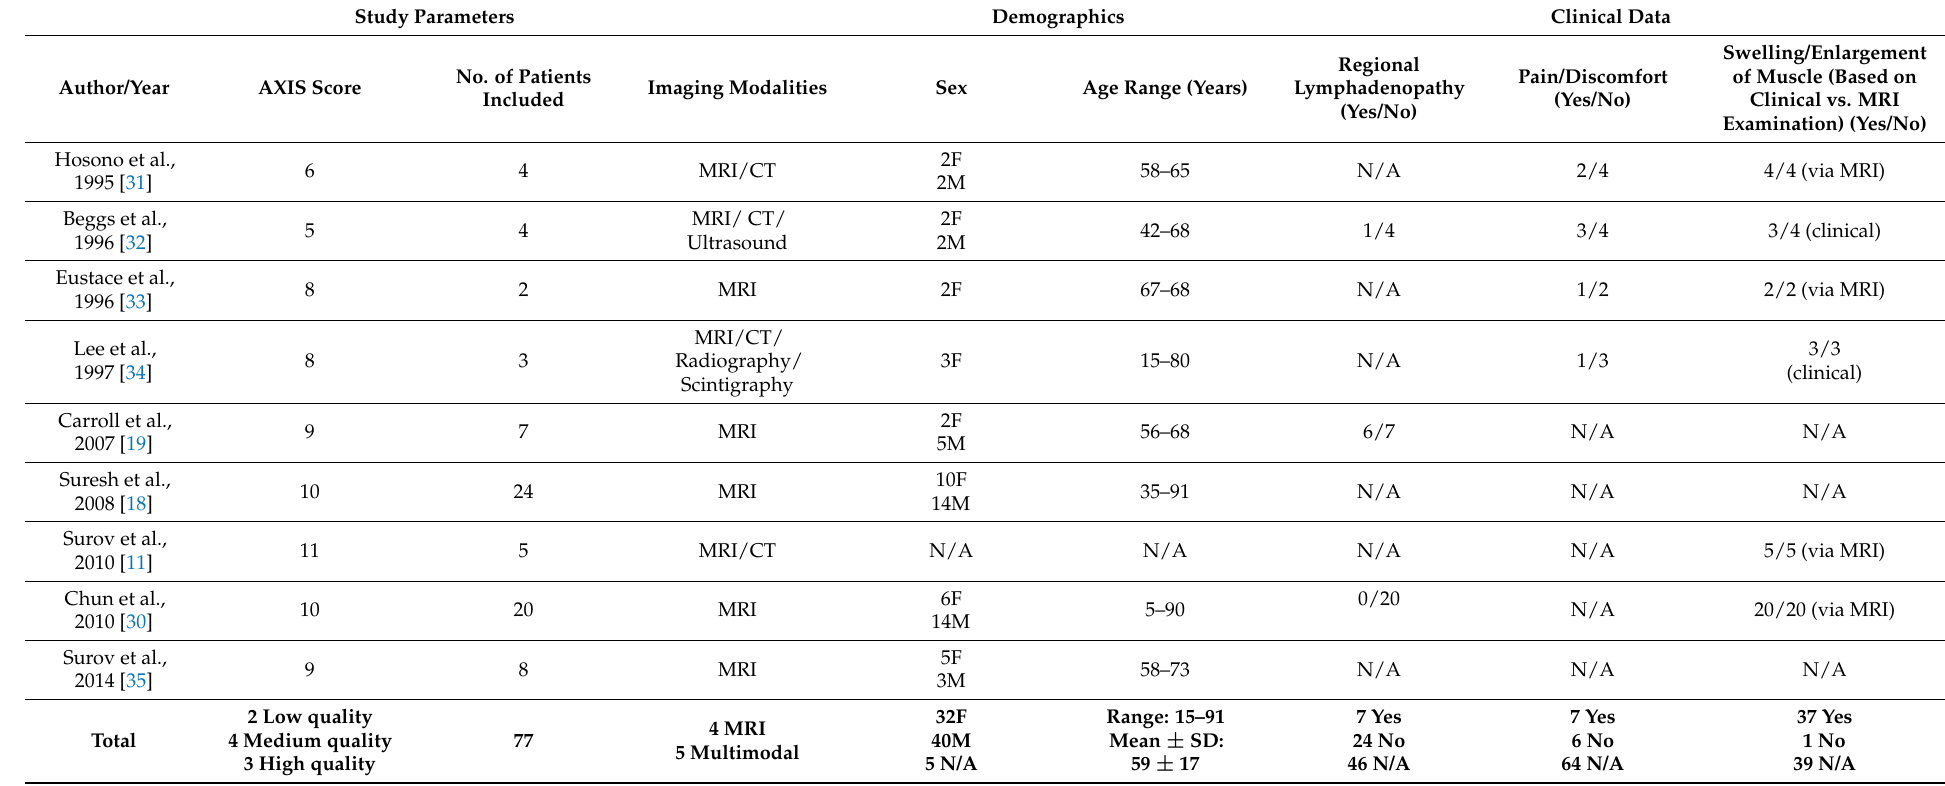
Table 3. Study parameters including demographics and clinical data (sorted by